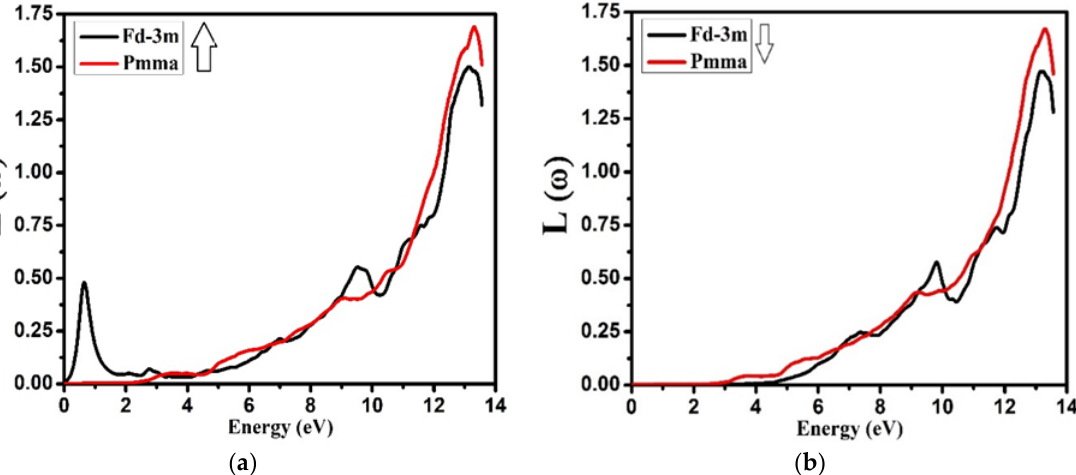
Figure 9. Calculated absorption coefficient I (ω) of Nd 2 Zr 2 O 7 ((black color for Fd-3m) and (red color for Pmma)) using GGA+U. ( a ) The spin-up direction ( ↑ ) and ( b ) spin-down ( ↓ ) direction.